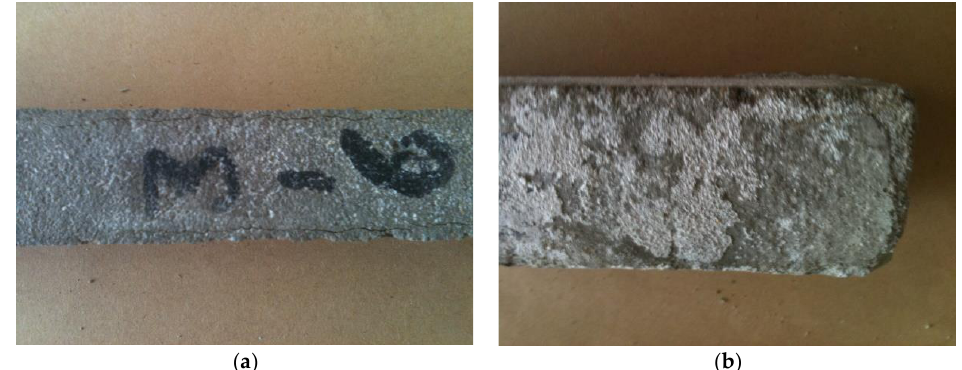
4 solution: ( a ) after 12 months; ( b )